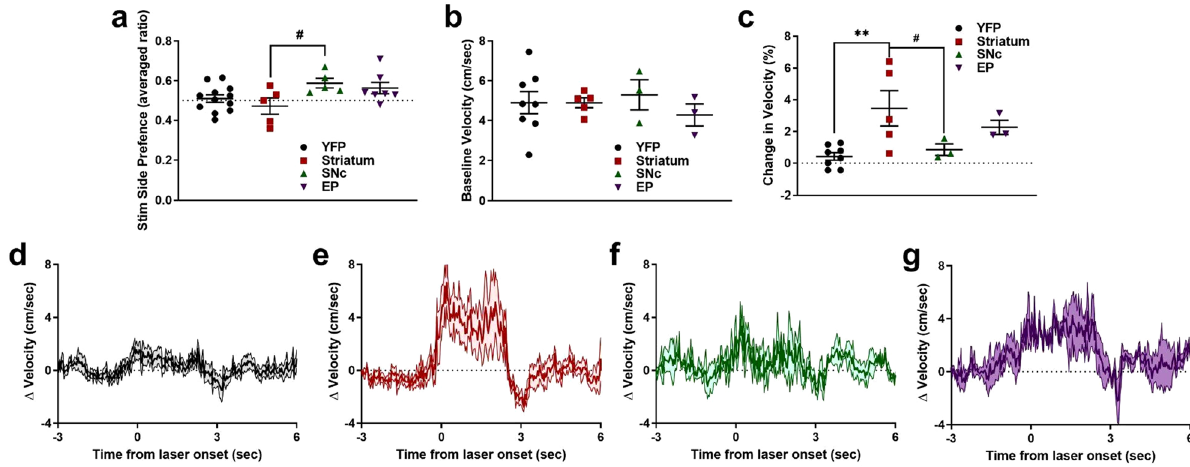
Figure 4. Effects of optogenetic stimulation of patches on reinforcement and locomotion. ( a ) Time spent on stimulated side of a two-chamber place preference apparatus. Time is averaged between two days, and the stimulated side was counterbalanced between days (see Methods). ( b ) Average velocity in the open field for YFP and ChR2 groups. ( c ) Change in velocity following laser onset in open field. ( d – g ) Average baseline normalized velocity before and after laser onset (5 Hz, 3 s; denoted by thick black line) for YFP ( d ), striatum ( e ), SNc ( f ), and EP ( g ) stimulation site groups. * p < 0.05; # p < 0.1; error bars,